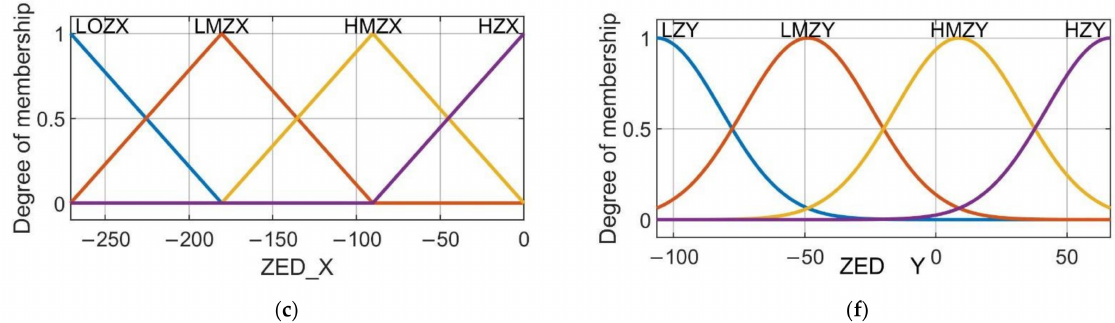
Figure 6. Membership functions used in the proposed model. ( a ) Membership functions for odometer data of latitude fuzzy system. ( b ) Membership functions for odometer data of longitude fuzzy system. ( c ) Membership functions for GPS data of latitude fuzzy system. ( d ) Membership functions for GPS data of longitude fuzzy system. ( e ) Membership functions for ZED camera data of latitude fuzzy system. ( f ) Membership functions for ZED camera data of longitude fuzzy